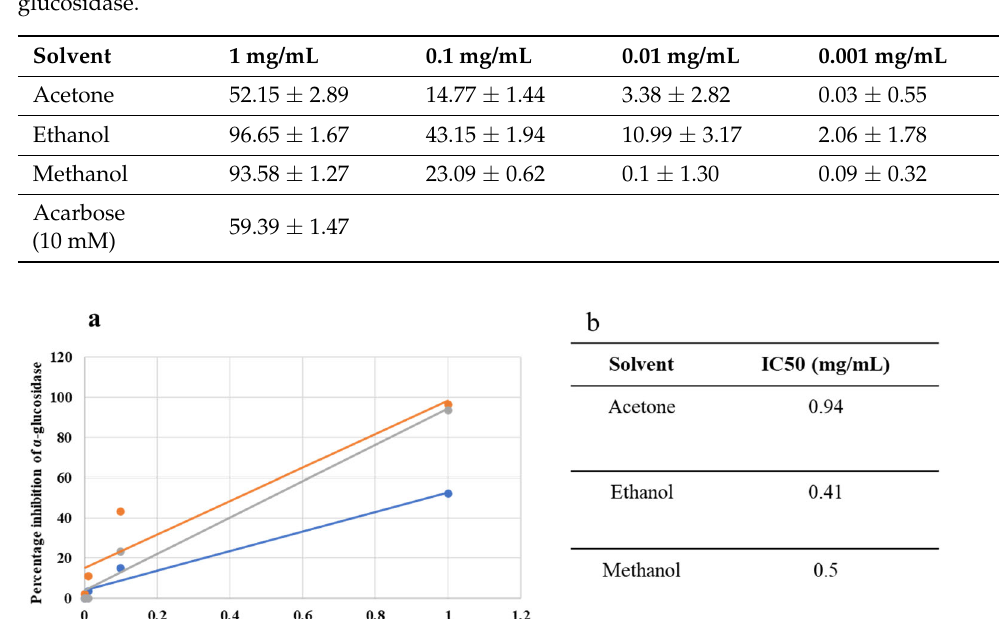
Figure 1. Dose–response curve ( a ) and IC 50 values ( b ) of acetone ‐ , ethanol ‐ , and methanol ‐ based extracts.